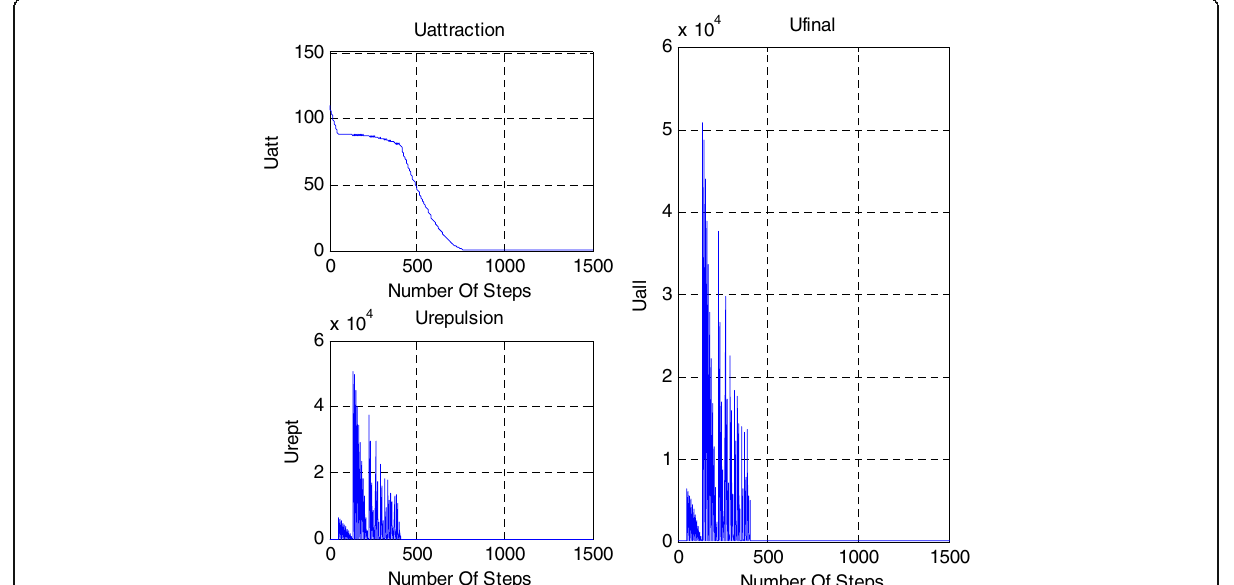
Fig. 21 The energy amount of repulsion and attraction and their yields according to the number of steps in the modified artificial potential field algorithm for the curve-shaped obstacle